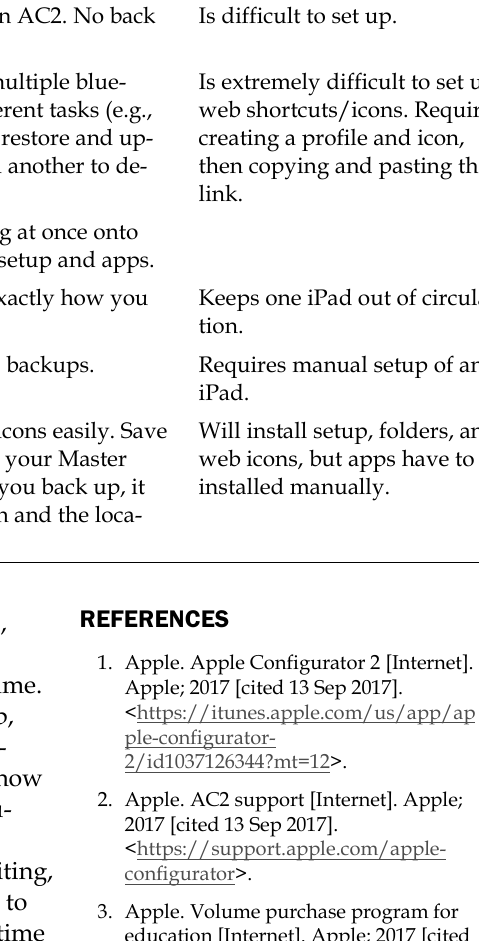
Table 1: Advantages and disadvantages of using a Blueprint versus Mas- ter iPad Advantages